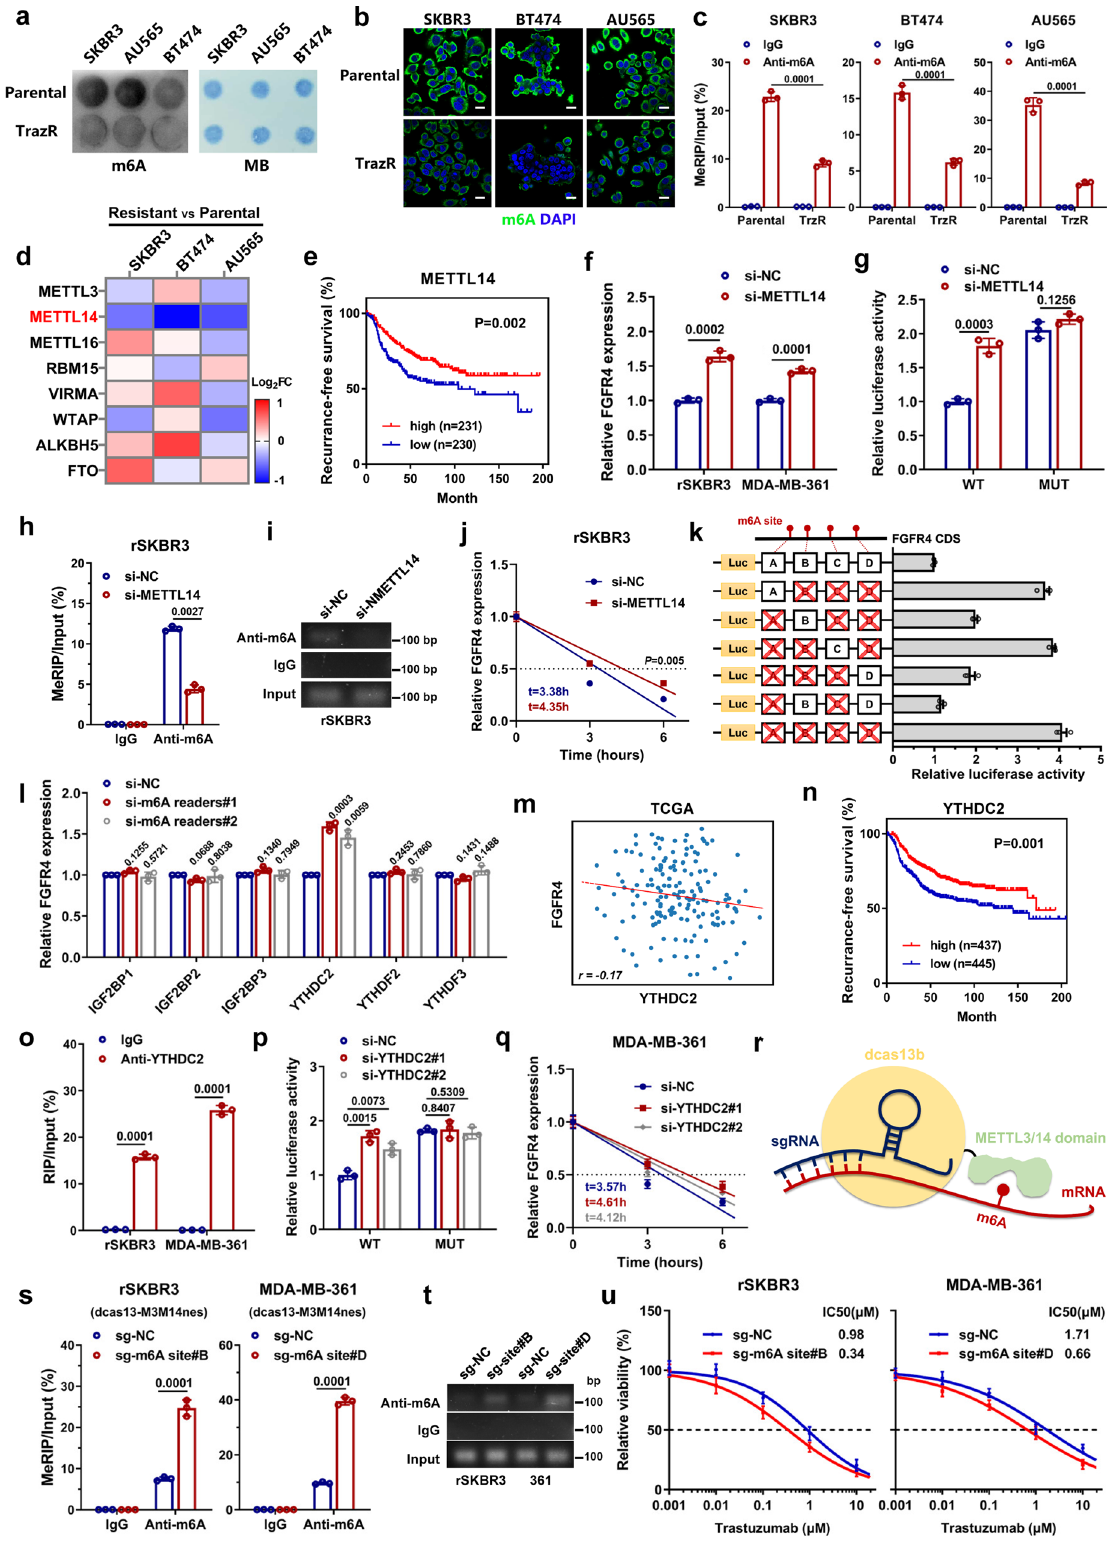
assumed that FGFR4 mediates anti-HER2 resistance via activat- ing WNT signaling pathway. Inconsistent with the hypothesis, knockdown of FGFR4 signi fi cantly reduced the phosphorylation of GSK-3 β and inhibited the WNT signaling pathway via downregulation of active β -catenin (Fig. 4e). The WNT sig- naling pathway was also blocked after treatment with